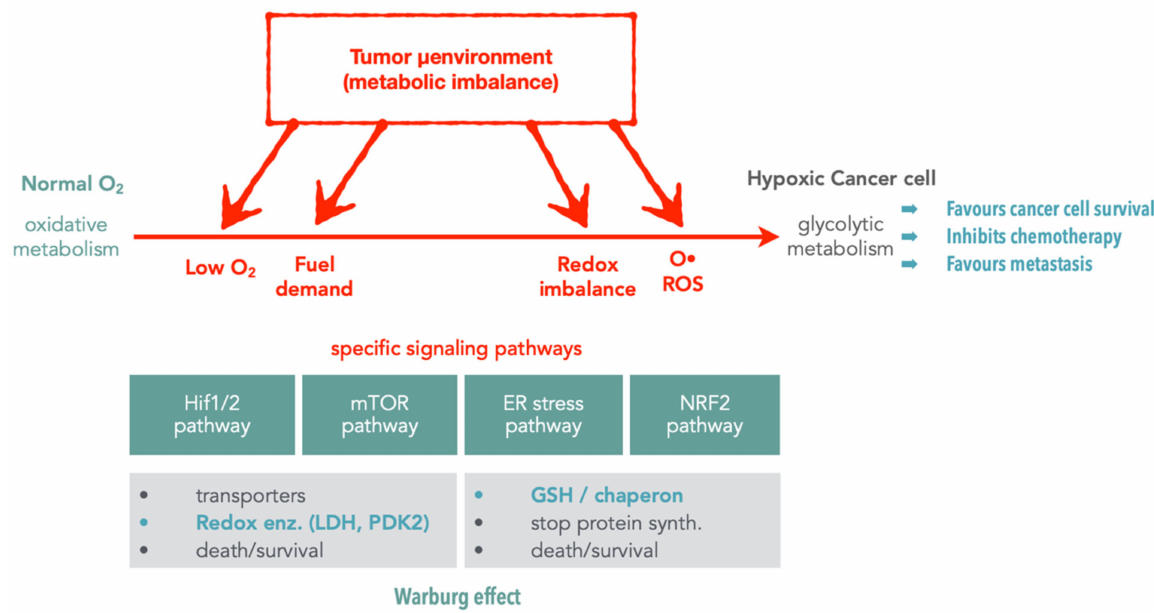
Figure 2. Metabolic/proteostasis pathways involved in tumor adaptation to their stressful environment. Upon metabolic imbalance (e.g., low oxygen content, elevated demand for fuel, redox imbalance, high production of ROS), cancer cells shift from an oxidative metabolism toward a glycolytic one induced by different pathways that detect the metabolic imbalances. These pathways include the HIF1/2, mTOR, ER stress and NRF2 mechanisms that contribute to the modification of the expression of transporters (ex. glucose transporters), redox enzymes (ex. LDH, PDK2), protein chaperones, and antioxidant enzymes (ex. GSH). This coordinated response allows cancer cells to